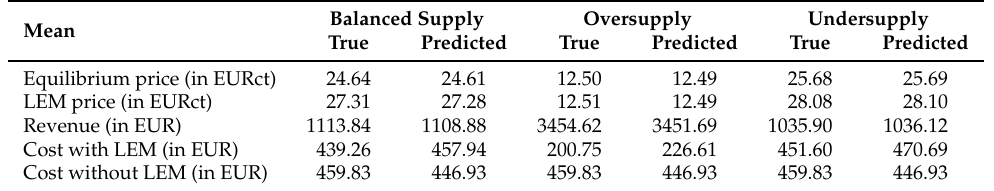
Table 4. Average results of the market simulation for three different supply scenarios. Prices are averaged across all trading periods. Revenues and costs for the whole simulation period are averaged across all prosumers and consumers,